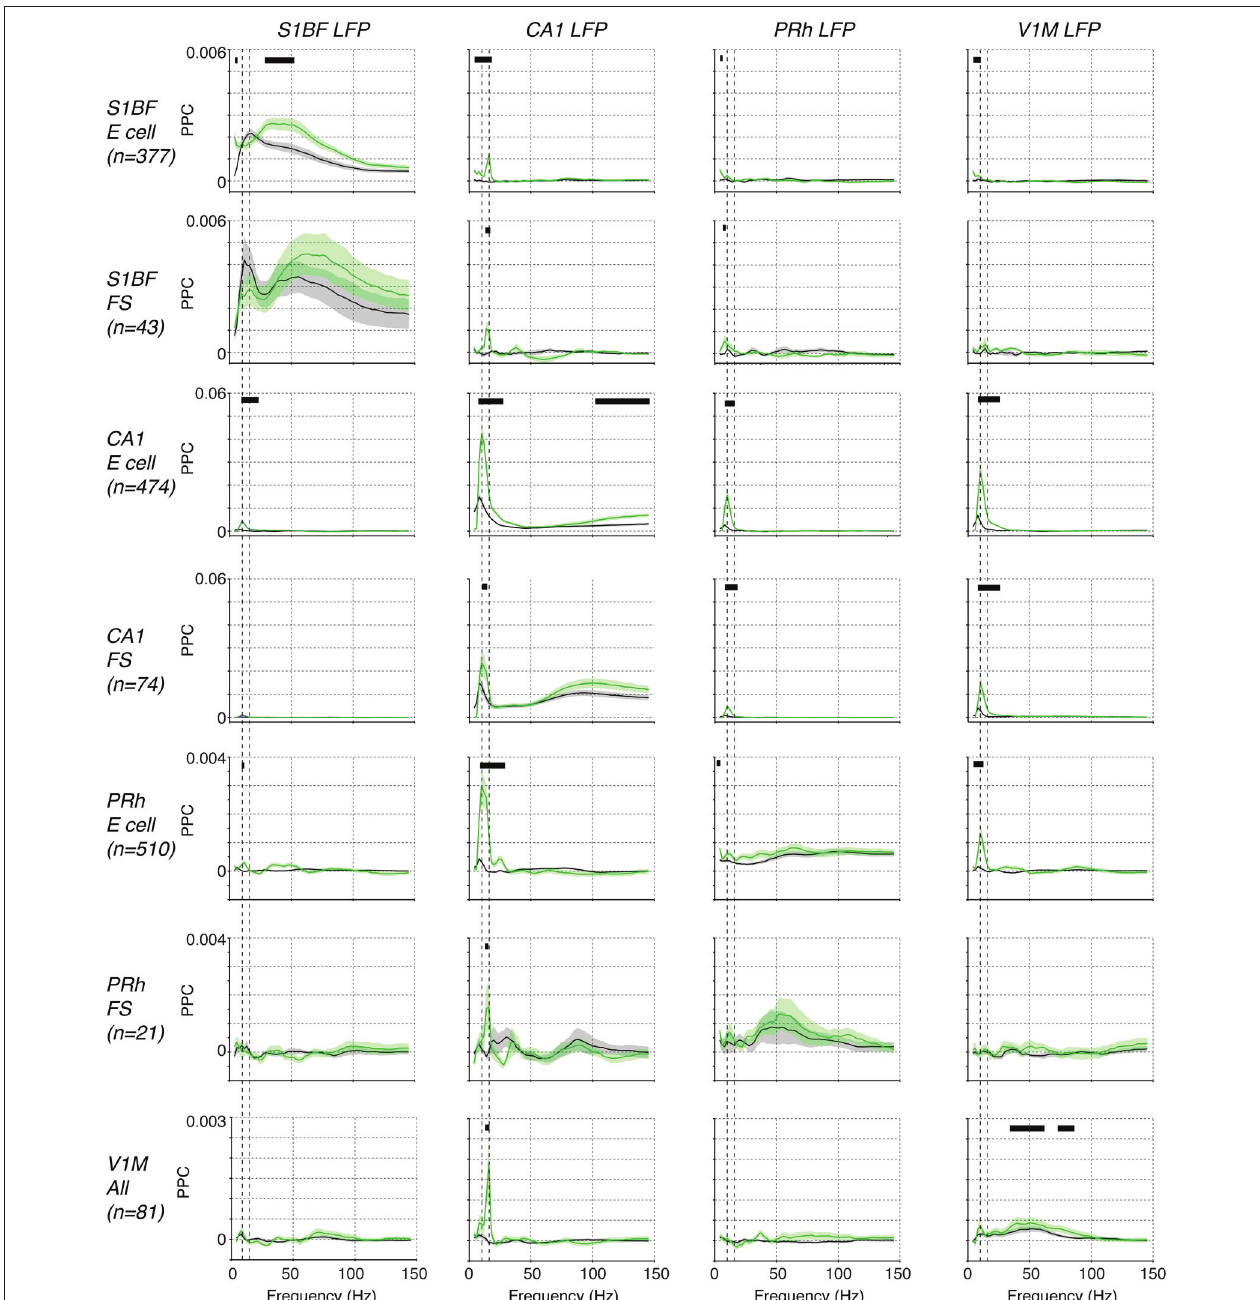
FIGURE 7 | Phase locking among S1BF, CA1, V1M, and perirhinal spikes and LFPs. Shown the mean ± SEM of spike-LFP PPC (Pairwise Phase Consistency) phase locking spectra, as a function of frequency (Hz). Displayed are locking spectra for S1BF FS and E cells, CA1 FS and E cells, PRh FS and E cells, and visual cortex cells. We pooled FS and E cells in visual cortex together because of the small sample size. Black horizontal lines indicate that two conditions held true: (1) there was a significant difference between baseline and locomotion ( p < 0.05), (2) the PPC-values for the period with the highest locking values exceeded zero ( p < 0.05, multiple comparison corrected randomization test, Korn et al., 2004). The second condition was used because a significant difference between baseline and locomotion would not have a meaningful interpretation if the PPC did not exceed zero in at least one condition. Vertical dashed lines indicate 8 and 14Hz peaks.